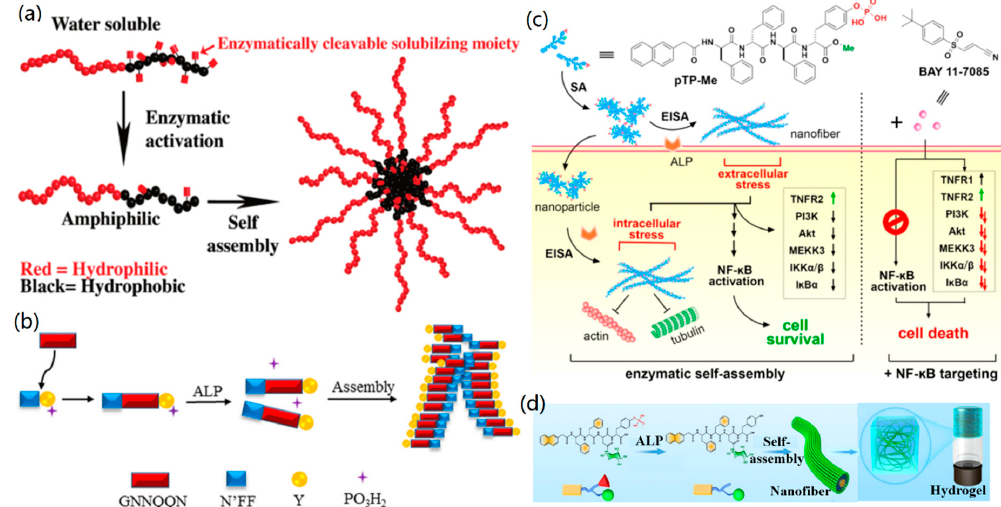
Figure 11. The enzyme-mediated self-assembly of biomolecules: ( a ) The enzyme-active